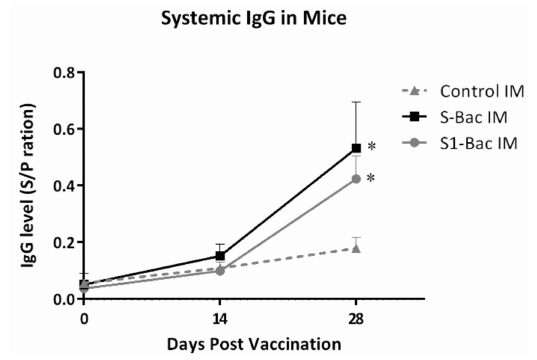
Figure 4. The changes of systemic porcine epidemic diarrhea virus (PEDV) spike (S)-specific IgG levels in S-Bac and S1-Bac vaccinated mice. The serum samples of the mice were collected three times in two-week intervals, including day 0 (pre-priming), 14 (2 weeks post-priming), and 28 (2 weeks post-boosting). The systemic anti-PEDV S protein IgG levels were detected by the PEDV S protein-based ELISA. The X axis represents the day post vaccination; whereas the Y axis shows the sample-to-positive control ratios (S/P ratio) of the optical density (OD) values from ELISA. The S/P ratio was defined as the ratio of the difference between the OD values of sample and negative control and the difference between OD values of positive and negative controls. The error bars represent the SD values of each group in different time points. The solid line with square icon and the gray line with round icon represent the climbing trend of IgG level in the S-Bac group and S1-Bac group, respectively. The IgG levels in the control group was expressed as the dotted line with triangle icon. *: significant difference with the control group ( p <